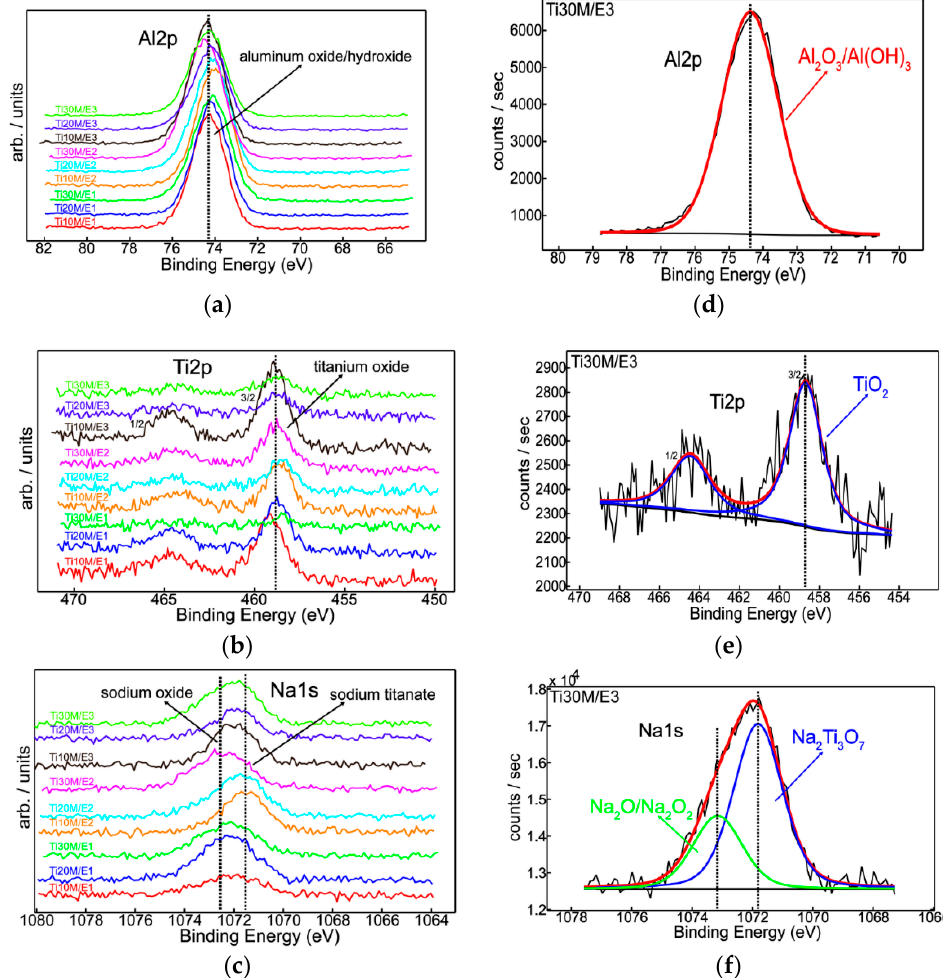
Figure 1. XPS spectra of the three sets of samples: ( a ) Al2p; ( b ) Ti2p; ( c ) Na1s. Peak-fitted XPS spectra of the third set of samples prepared in E3 electrolyte: ( d ) Al2p; ( e ) Ti2p; ( f ) Na1s. Table 1. Element relative concentrations (at.%).